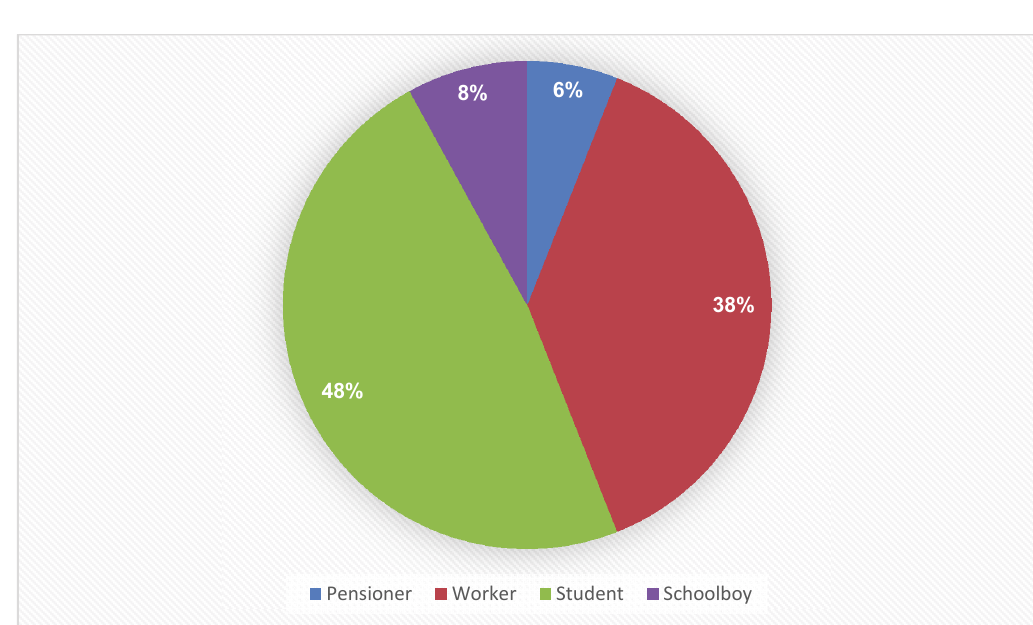
Fig. 2. Structure of consumers by type of